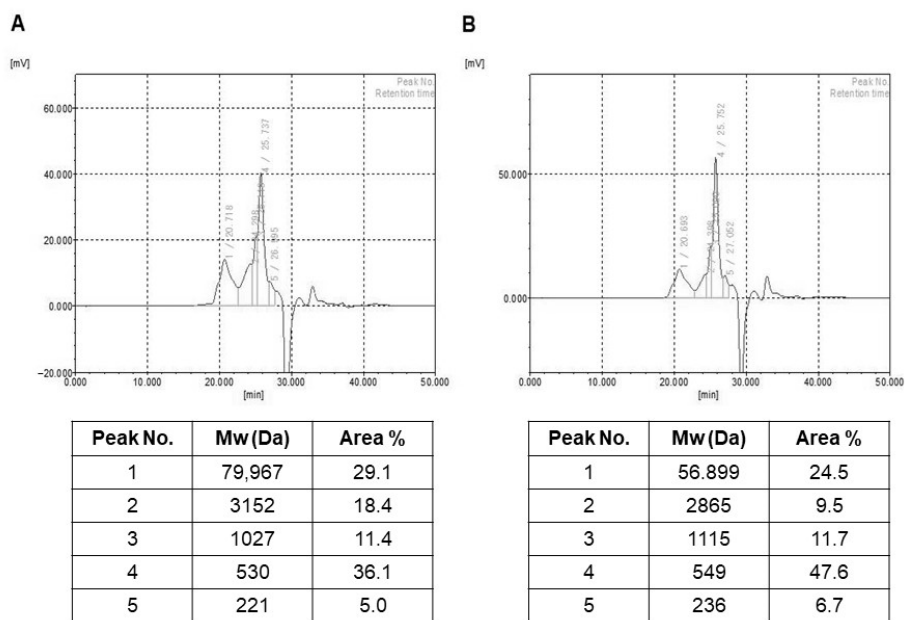
Figure 1. Gel permeation chromatography (GPC) analysis of lactic acid bacteria EPS. GPC chromatogram and peak information of ( A ) L. plantarum HY7714 and ( B ) L. plantarum HY7711. 2.3. Effect of HY7714 EPS Treatment on Tight Junctions and Inflammatory Cytokines in Intestinal